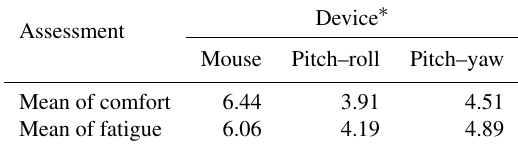
Table 6. The result of rating of perceived exertion (RPE) assess- ment using the Borg